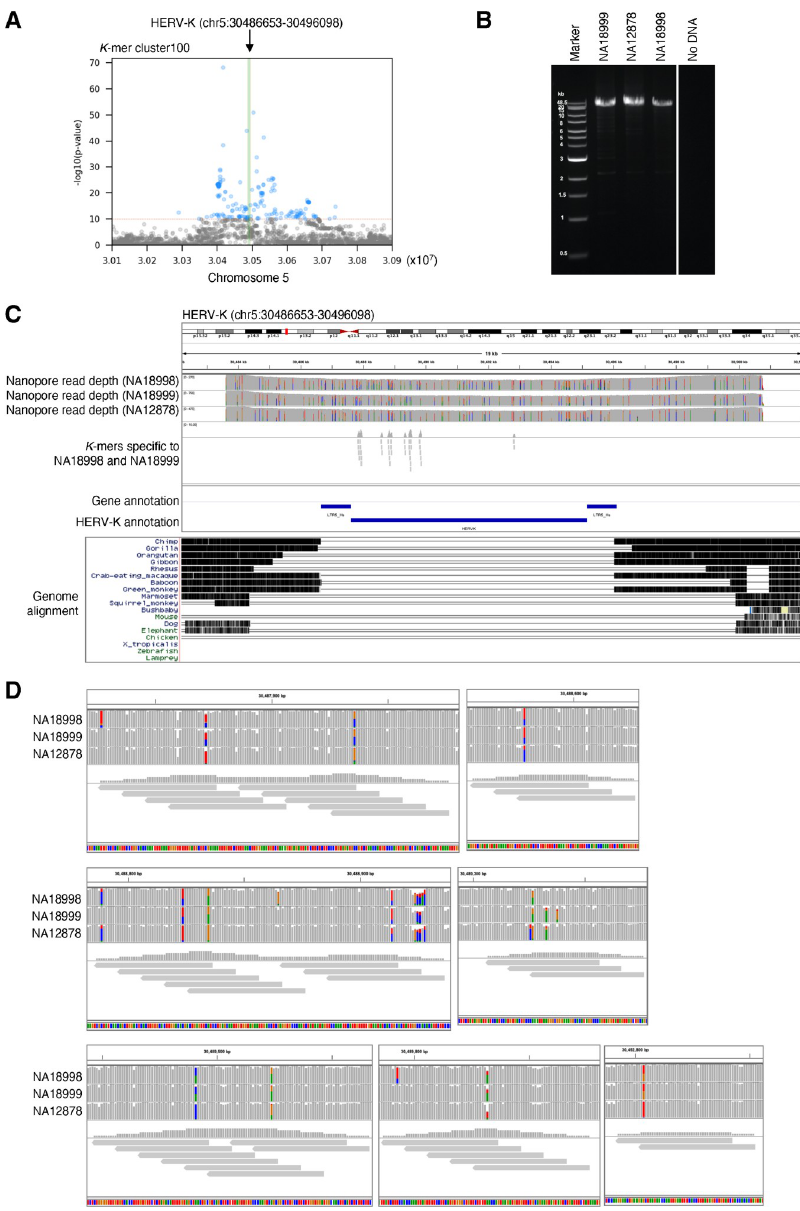
Fig 7. Potential interlocus gene conversion in HERV-K localized by LDfred. A. Manhattan plot showing SNVs associating the k -mer cluster100. SNVs with p-value lower than 8.33e-11 are shown as blue dots. Green line shows the reference HERV-K provirus. B. Amplification of the HERV-K provirus by PCR. HERV-K provirus with adjacent sequence was amplified and PCR products were separated by gel electrophoresis. DNA extracted from LCLs originating from NA18998, NA18999, and NA12878 were used as templates. C. Upper panel: IGV view of long-read sequencing reads mapping to HERV-K. The PCR amplicons were sequenced using an Oxford Nanopore flongle flow cell and mapped to GRCh38. k -mers in k -mer detecting the HERV-K were also mapped to the PCR target regions. Lower panel: UCSC genome browser view showing the Multiz Alignment of 100 Vertebrates track. D. Enlarged images of panel C. NA12878 carries two alleles of a non-reference HERV-K haplotype (which is not observed elsewhere in the reference genome) also present as a single allele in NA18998 and NA18999.